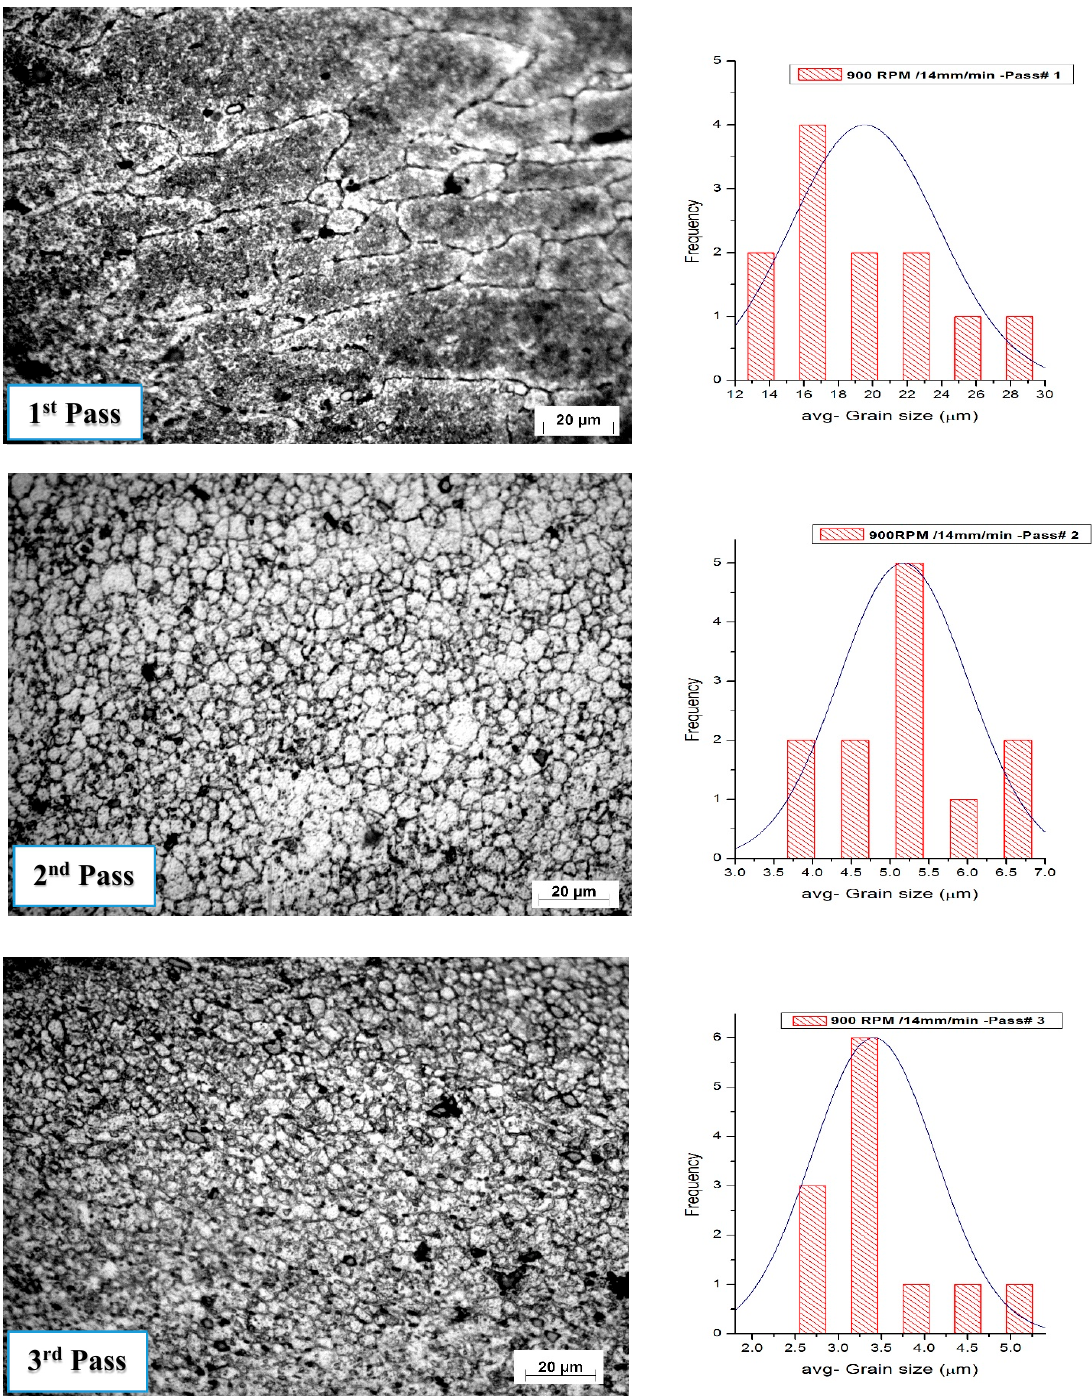
Figure 15. Optical micrographs with histogram showing grain structure and distribution in the stirring zone in friction stir-processed samples at a 900 rpm rotation speed and a 15 mm/min traverse speed.